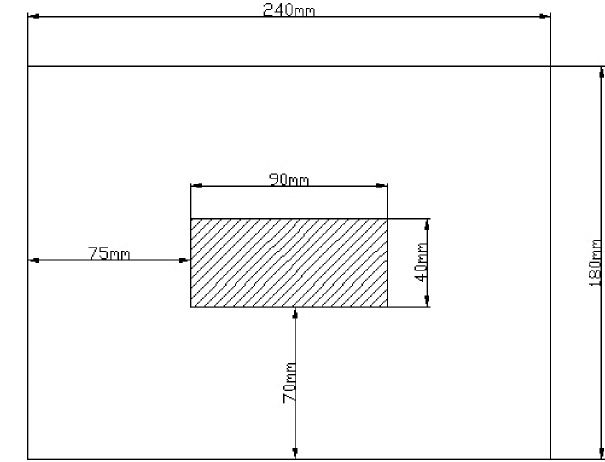
Fig. 2: The calculated temperature profiles with measured data points at three different cases